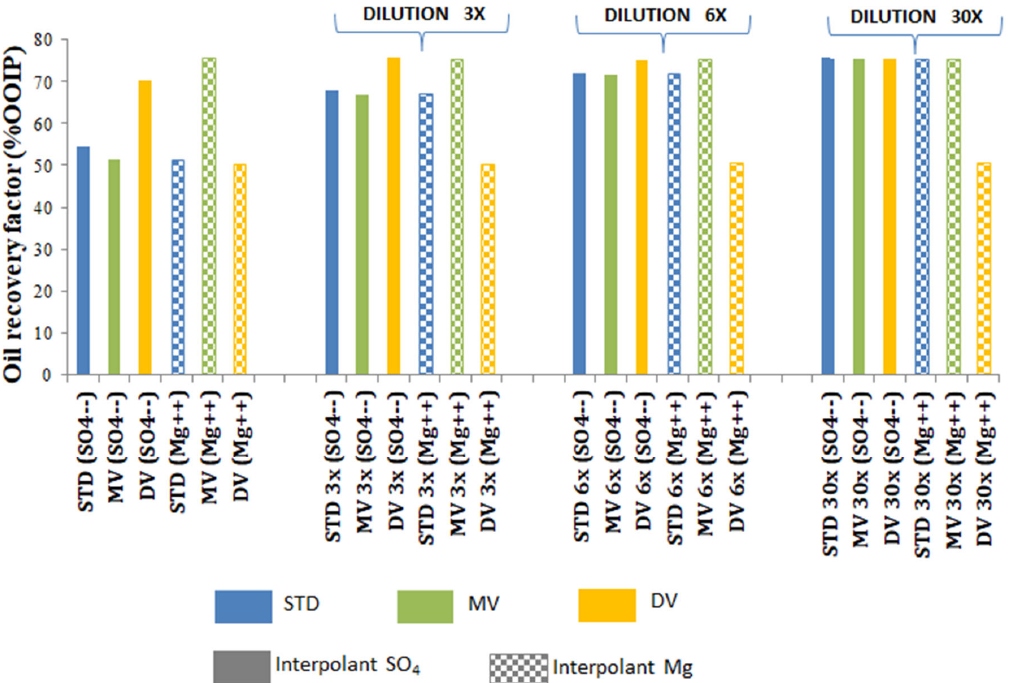
Figure 4. Oil recovery factor versus adopted approach for each simulation.